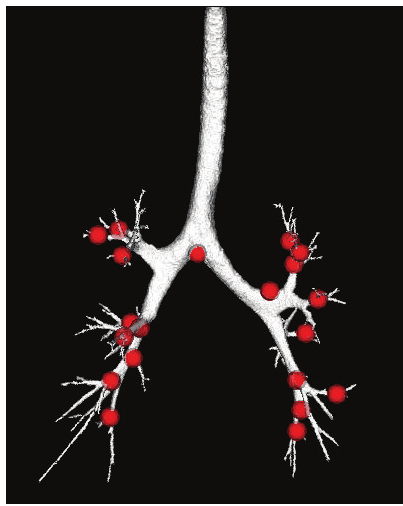
Figure 3: Distribution of landmark positions (red points) selected on the airway tree from the baseTLC image of one